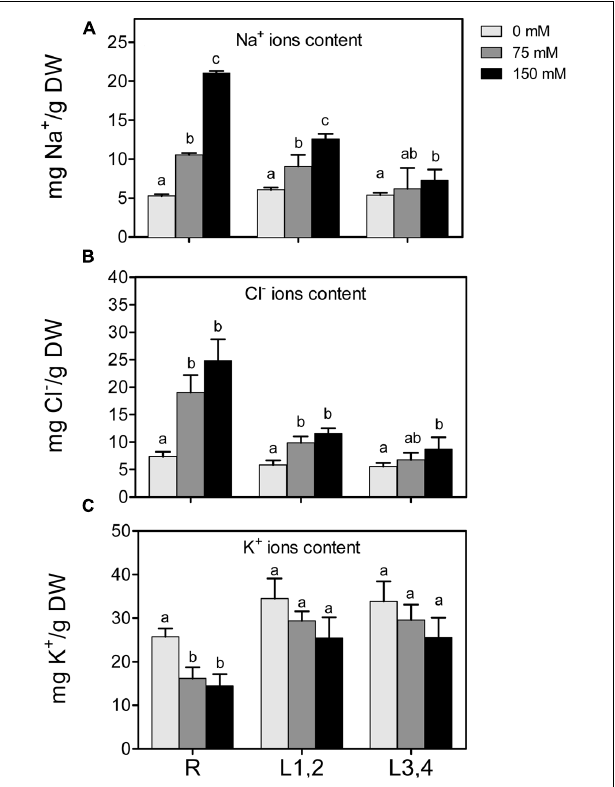
FIGURE 1 | Effect of different salinity levels on dry weight (DW) of root (R), mature leaf pair (L1,2), and young leaf pair (L3,4) of 3 weeks old maize seedlings. Values are means of at least three replicates and significant differences between means, as determined by Duncan test ( P < 0.05), are indicated by different letters.